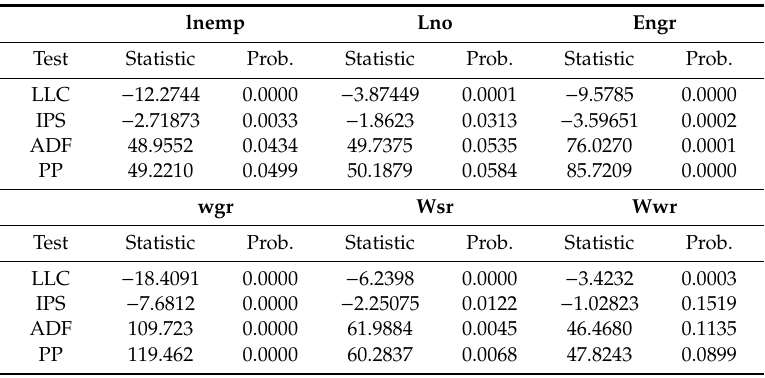
Table 4. Stationarity test of the unit root of clean industries